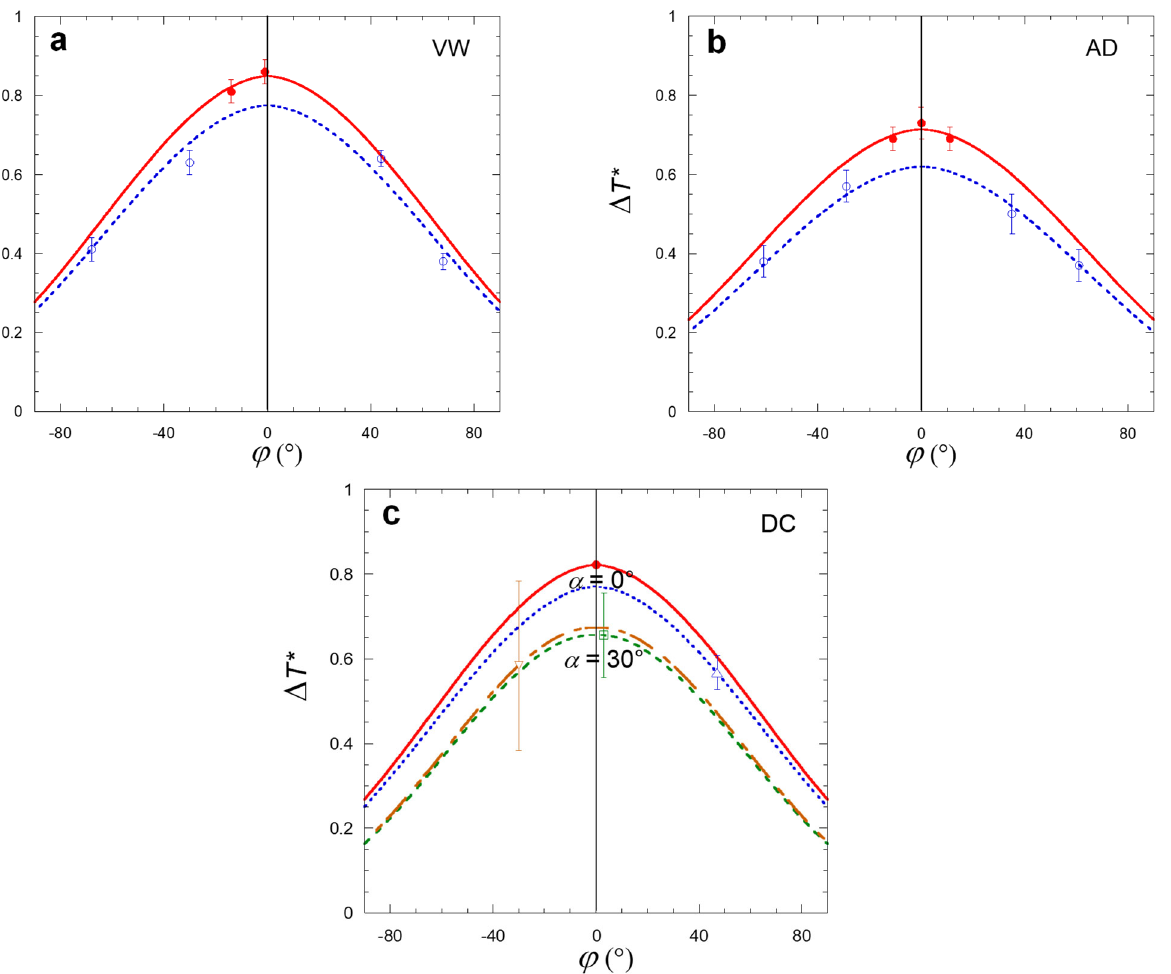
Figure 12. Variation with tilt angle ϕ of the temperature efficiency ∆ T ∗ for the VW, AD, and DC cars, fitted to Equation (30) by using the polynomial functions Equations (32) and (33) with a j / a 0 as adjustable parameters (curves). The isolated surfaces (RT, FH) are fitted separately from the non-isolated surfaces (WS, BW, LW). ( a ) Mean values for the VW car in Ajaccio. ( b ) Mean values for the AD car in Ajaccio. ( c ) DC car in Valparaiso. Red full circle and continuous curve: RT thermally isolated surface and obstacle view angle α ≈ 0 ◦ . Blue open triangle and dotted curve: Non-isolated BW surface and α ≈ 0 ◦ . Brown inverted triangle and double-interrupted curve: Non-isolated WS surfaces and α ≈ 30 ◦ . Green open square and interrupted curve: Non-isolated BT surface and α ≈ 30 ◦